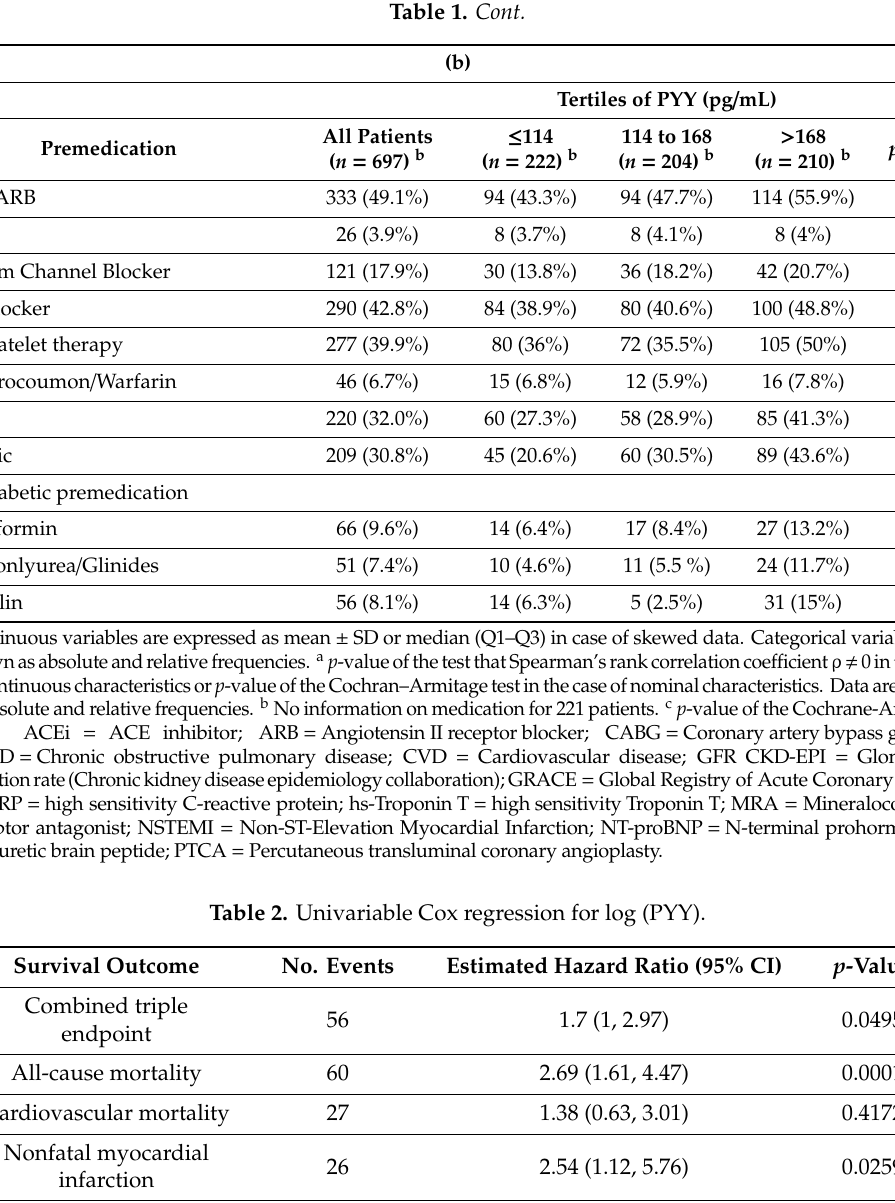
(Table 3; multivariable Model 2). No significant association of PYY with 3-P-MACE was found by multivariable Cox regression analyses (Table